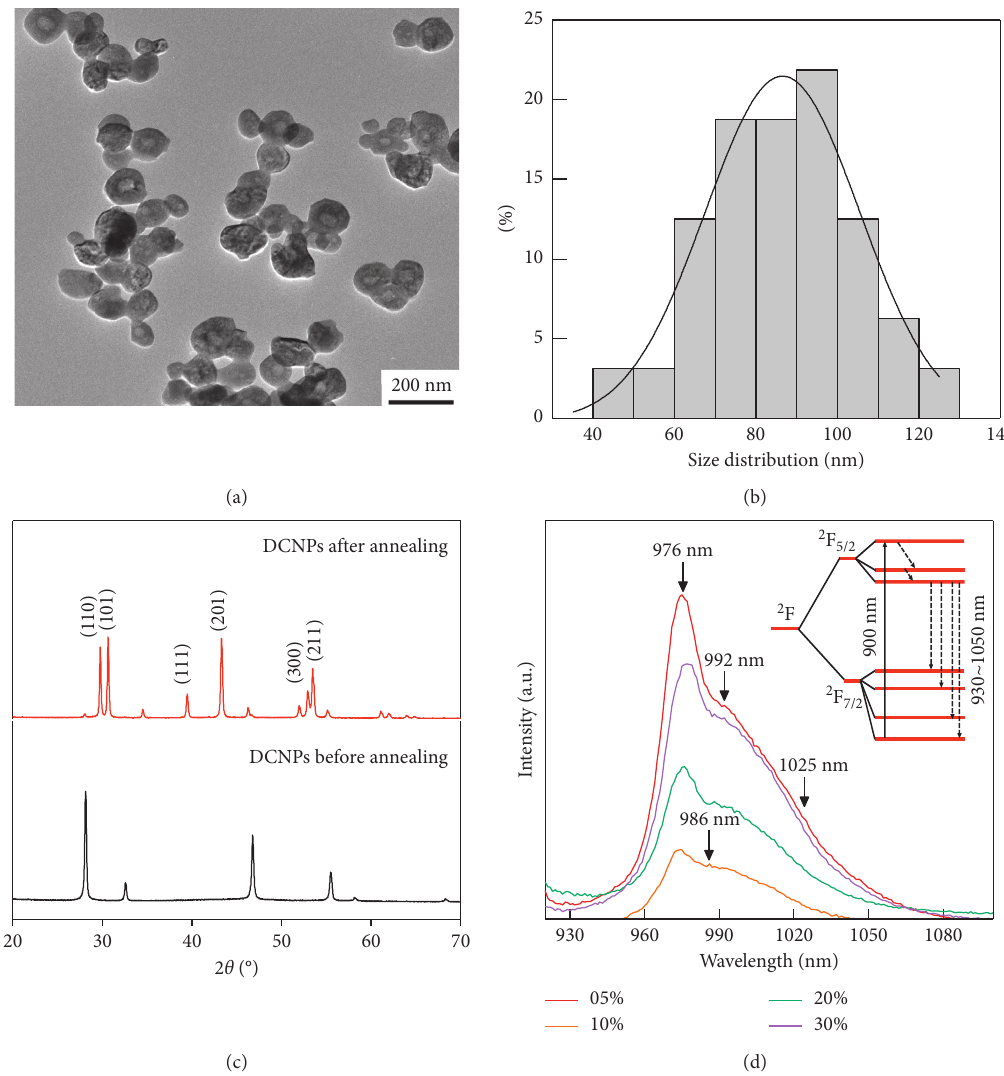
Figure 1: (a) TEM images of DCNPs. (b) Size distribution of DCNPs. (c) XRD patterns of DCNPs. (d) PL spectra of DCNPs upon 900nm excitation at various ytterbium doping concentrations, ranging from 5% to